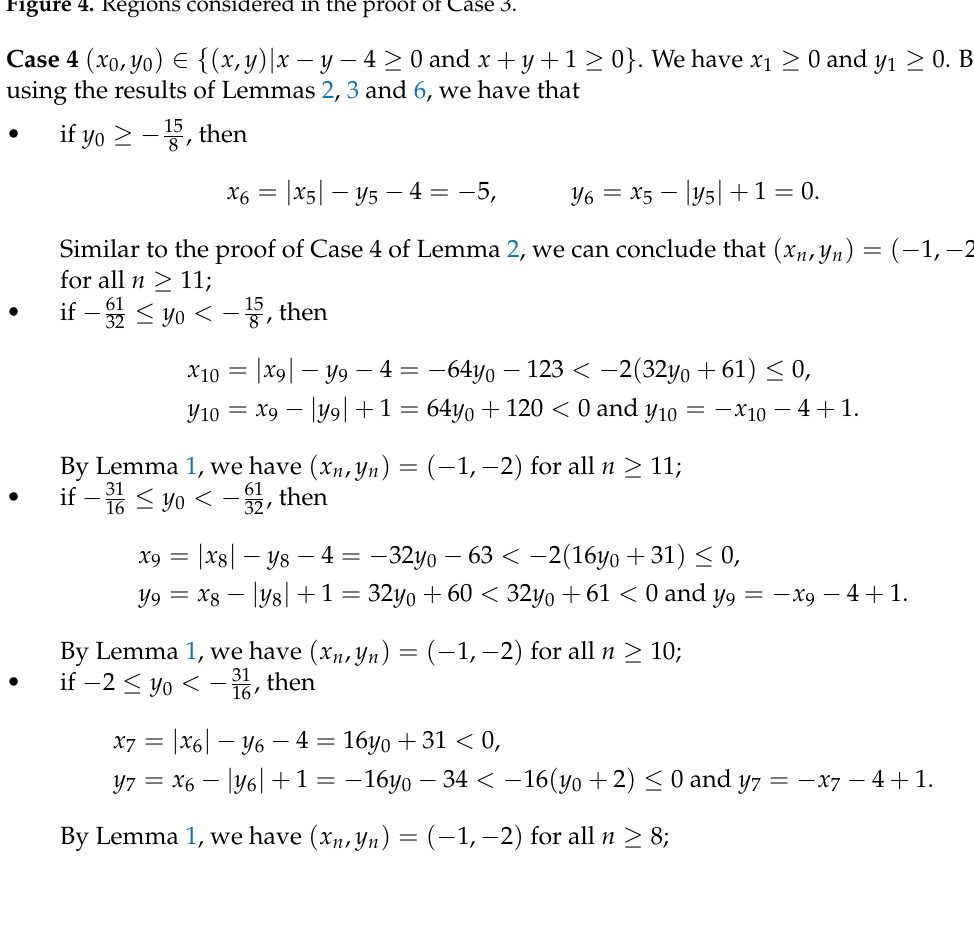
Figure 4. Regions considered in the proof of Case